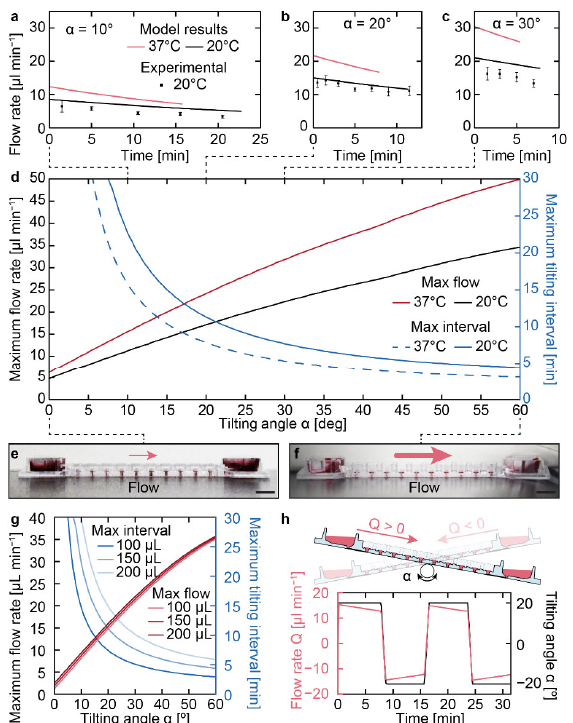
Figure 7. Tilting-angle-dependent perfusion of the chip using an initial liquid volume of 150 μL. ( a – c ) Flow rate as a function of time at tilting angles α of ( a ) 10°, ( b ) 20°, and ( c ) 30°. Measured values at 20 °C (12 measurements; data represented as mean ± SD) matched the calculated flow rates over time and allowed for extrapolation to an experimentally relevant temperature of 37 °C. Slopes of the decreasing flow rates over time at 20 °C amounted to −0.16 ± 0.018, −0.30 ± 0.037, and −0.54 ± 0.104 μL min −2 for the measured values and −0.16 ± 0.001, −0.30 ± 0.001, and −0.41 ± 0.001 μL min −2 for the calculated values at tilting angles of 10°, 20°, and 30°, respectively. ( d ) Maximum flow rate and tilting interval until drainage of the top reservoir at 20 and 37 °C as a function of the tilting angle. The curves for initial liquid volumes of 100 and 200 μL can be found in subfigure ( g ). Representative side views of the chip at ( e ) 0° and ( f ) 60° showing the stability of the standing drops at large tilting angles (scale bars = 5 mm). ( g ) The maximum flow rate and tilting interval until drainage of the top reservoir at 37 °C as a function of the tilting angle was calculated for initial liquid volumes of 100, 150, and 200 μL. Lower liquid volumes resulted in lower flow rates and shorter applicable tilting intervals. ( h ) Bidirectional flow rate through the channel upon repeated tilting over two tilting cycles with the following parameters: tilting angle α = 20°, tilting interval = 7 min, and transition time = 50 s. Adapted with permission from Lohasz et al. [9]. 2018, Elsevier.